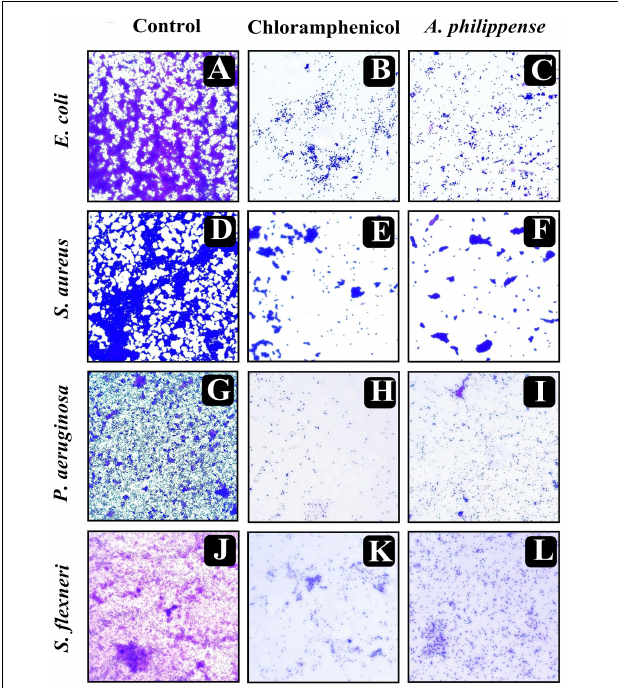
FIGURE 6 | Micrographs of disrupted matured biofilms of tested strains formed on glass surfaces by the A. philippense crude extract at their respective MICs by fluorescent microscopy (at 40x magnification). (A,D,G,J) Growth control; (B,E,H,K) Positive control chloramphenicol; and (C,F,I,L) A. philippense crude